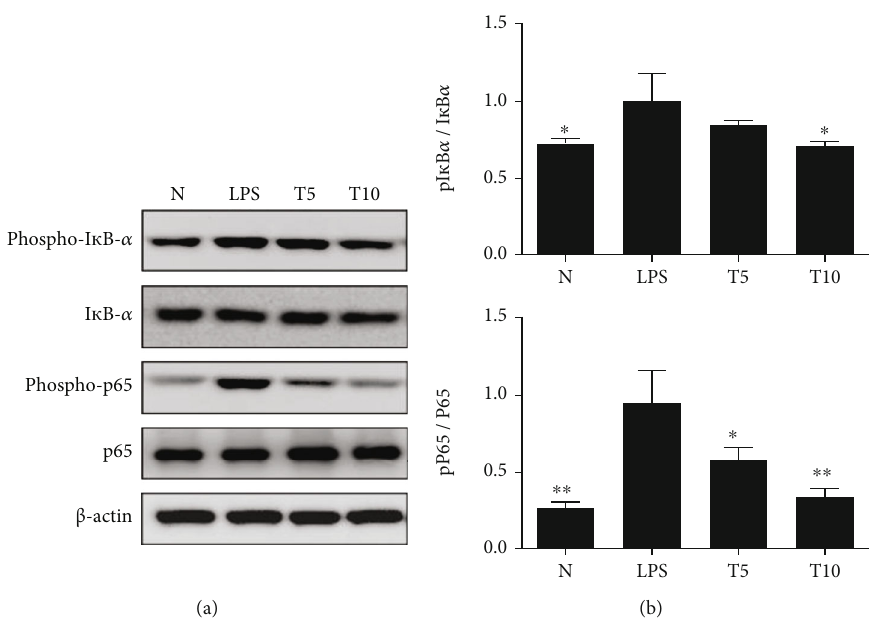
Figure 7: Tomatidine regulated NF- κ B pathway in the lung of mice. (a) Tomatidine increased I κ B- α and p65 phosphorylation in the lung. (b) The fold change in the expression of phosphorylated I κ B α and phosphorylated p65 protein was measured relative to the expression of I κ B α and p65, respectively. Data are presented as the mean ± SEM . ∗ p < 0 : 05 and ∗∗ p < 0 : 01 vs. LPS group. N group: normal control mice; LPS group: LPS treatment only; T5 group: 5 mg/kg tomatidine plus LPS; T10 group: 10mg/kg tomatidine plus